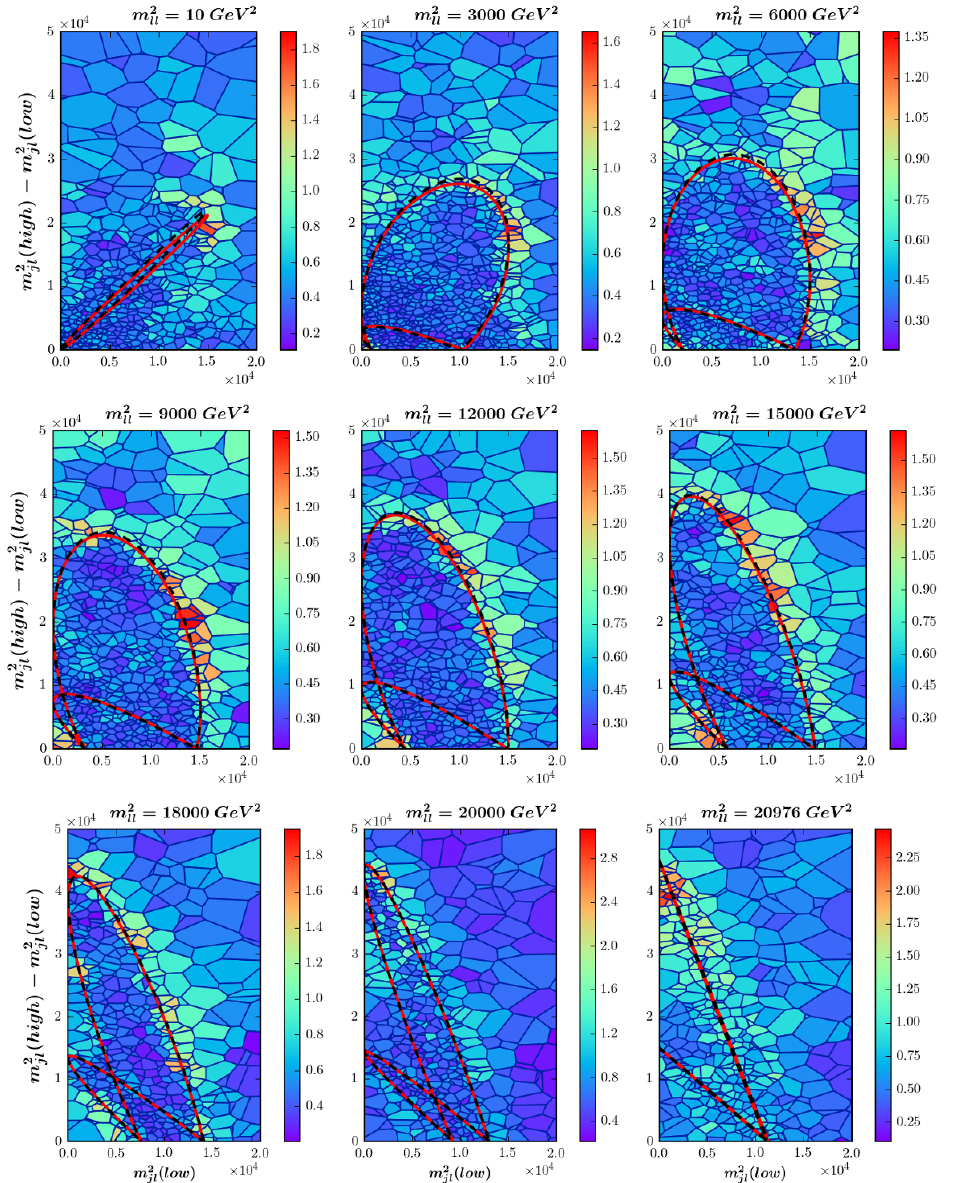
Figure 14 . The analogue of (cid:12)gure 12 for the exercise with t (cid:22) t background events considered in section 3.3. The Voronoi tessellation was done for the case of N B = 3000. The red solid line is the phase space boundary for the nominal value m A = 236 : 6 GeV, while the black dashed line corresponds to the best (cid:12)t value ~ m A = 280 : 0 GeV found in the top left panel of (cid:12)gure 13.